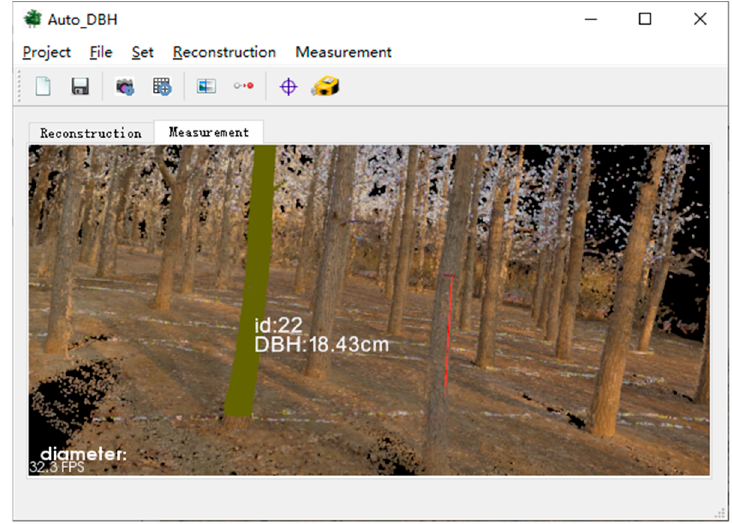
Figure 7. The interface of Auto-DBH, in which dense point cloud of the reconstruction was presented after DBH estimation. The scale was determined with a one-meter long red line on the right. A tree was selected and labeled with DBH information on the left.